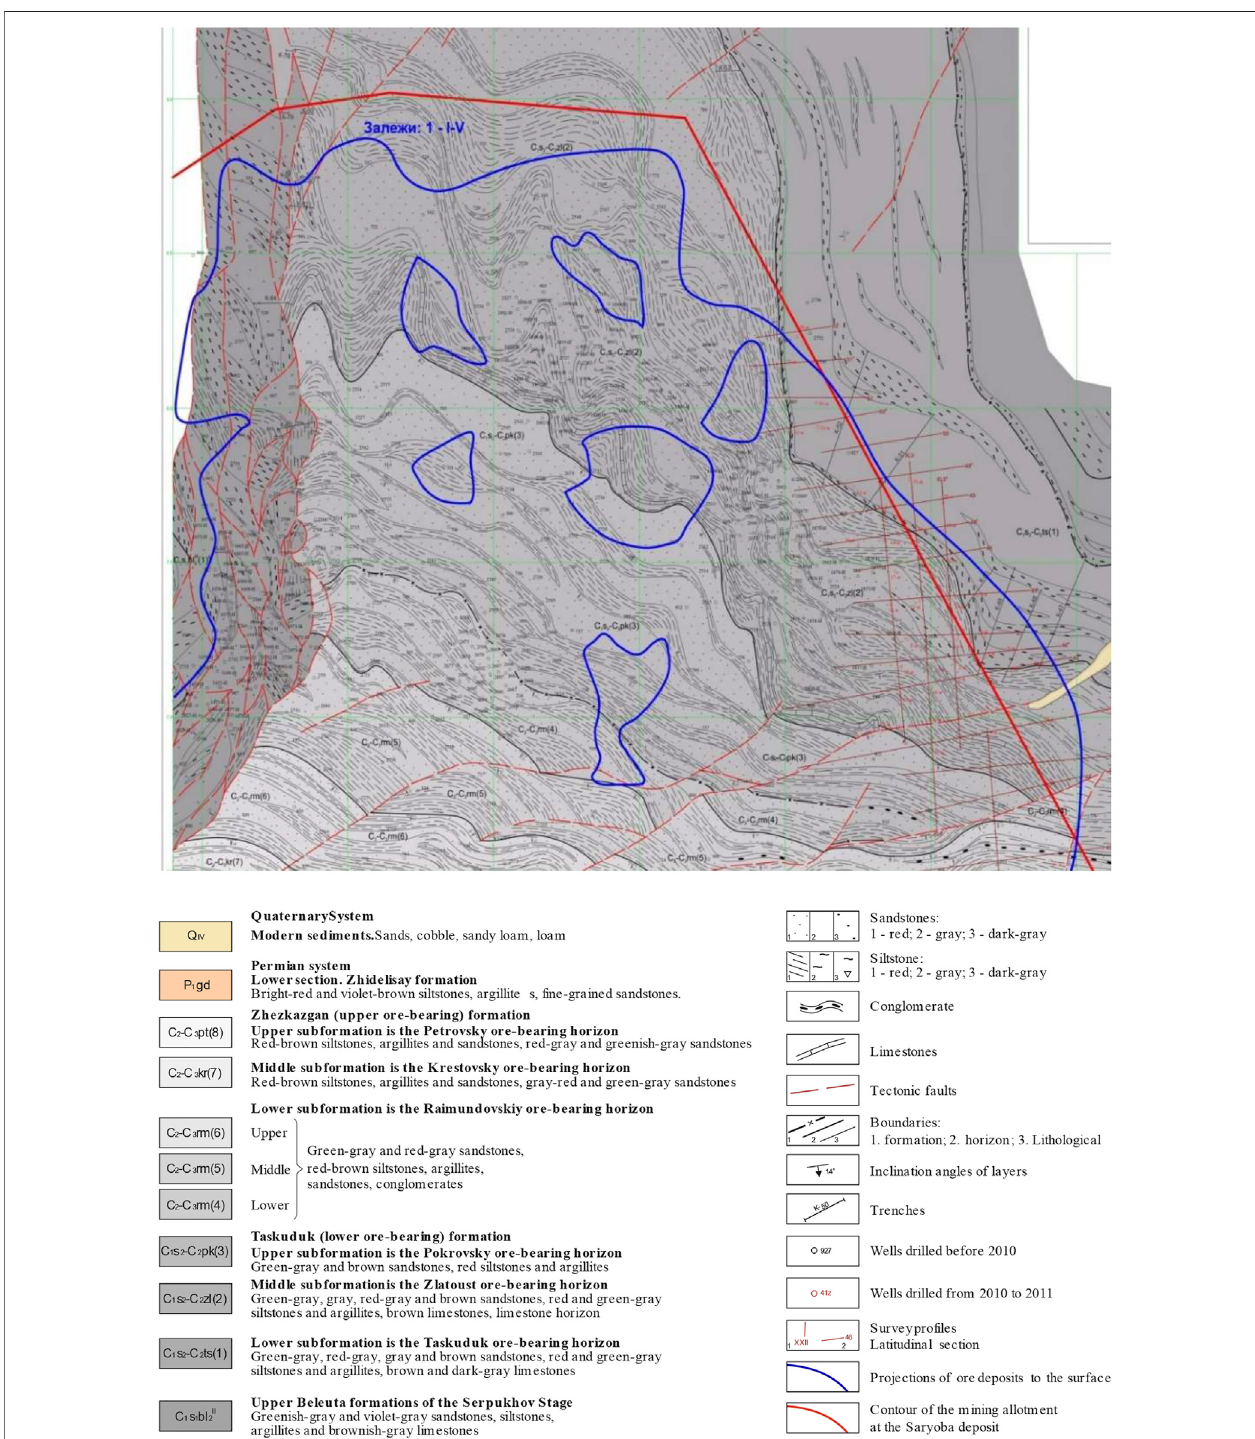
FIGURE 4 | Geological map of the Taskuduk horizon at the Saryoba deposit.